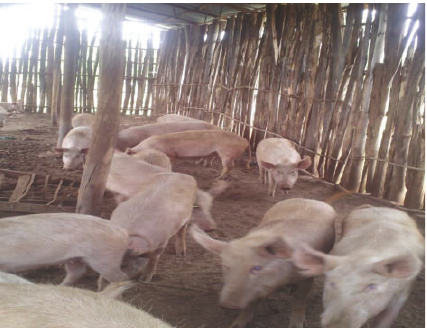
Figure 2: Pigs roaming around the homestead in study area.